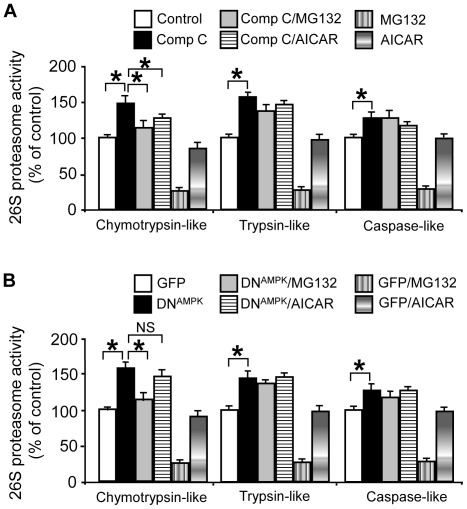
AMPK suppression increases 26S activity in HUVEC.AMPK suppression in HUVEC either by (A) compound C (10 µmol/L for 2 hour) or by (B) overexpression of AMPK-dominant negative mutant (DN) increases 26S proteasome activities, as demonstrated by ATP-dependent increased chymotrypsin-like, trypsin-like and caspase-like activity on fluorescent proteasome substrates. MG132 (0.5 µmol/L for 1 hour) or AICAR (2 mmol/L for 6 hours) treatment blocks the increased chymotrypsin-like activity in AMPK-suppressed HUVEC. * indicates P<0.05 vs vehicle (DMSO) or GFP, n = 3 per group.